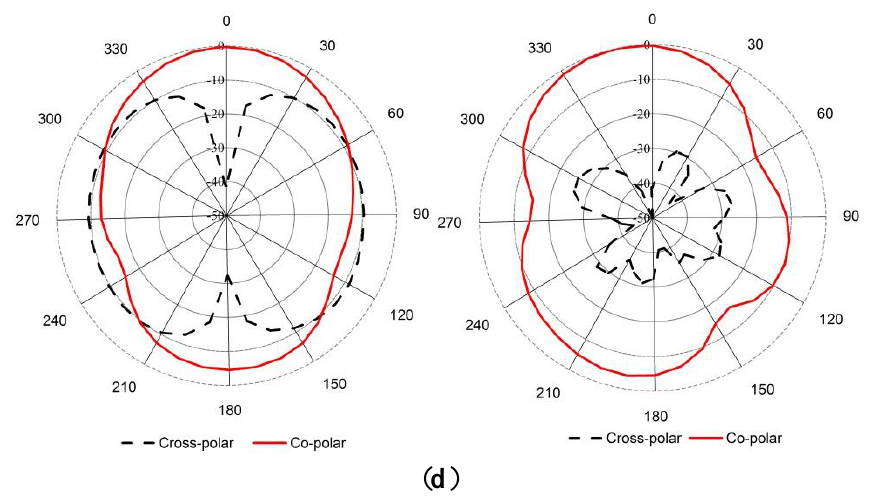
Figure 10. Measured radiation pattern of the proposed antenna at ( a ) 4 GHz; ( b ) 6 GHz; ( c ) 9 GHz and ( d ) 12 GHz.